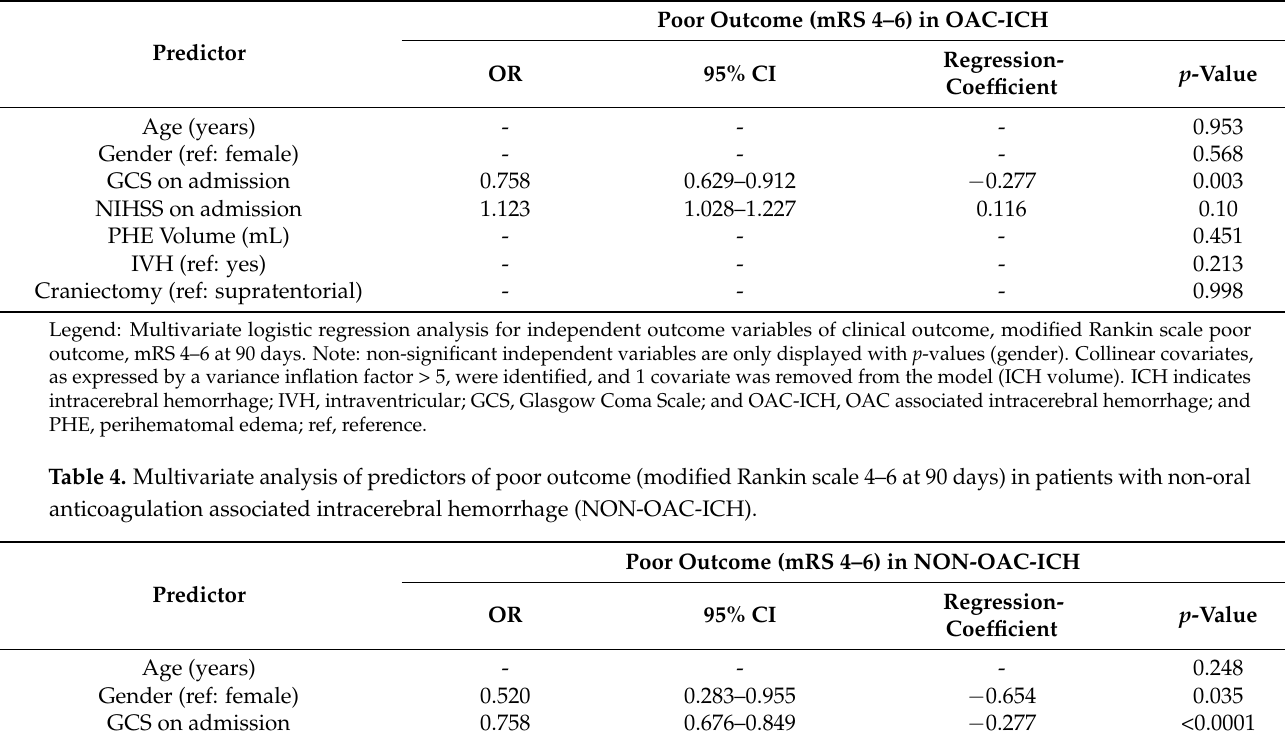
Table 3. Multivariate analysis of predictors of poor outcome (modified Rankin scale 4–6 at 90 days) in patients with OAC associated intracerebral hemorrhage (OAC-ICH).